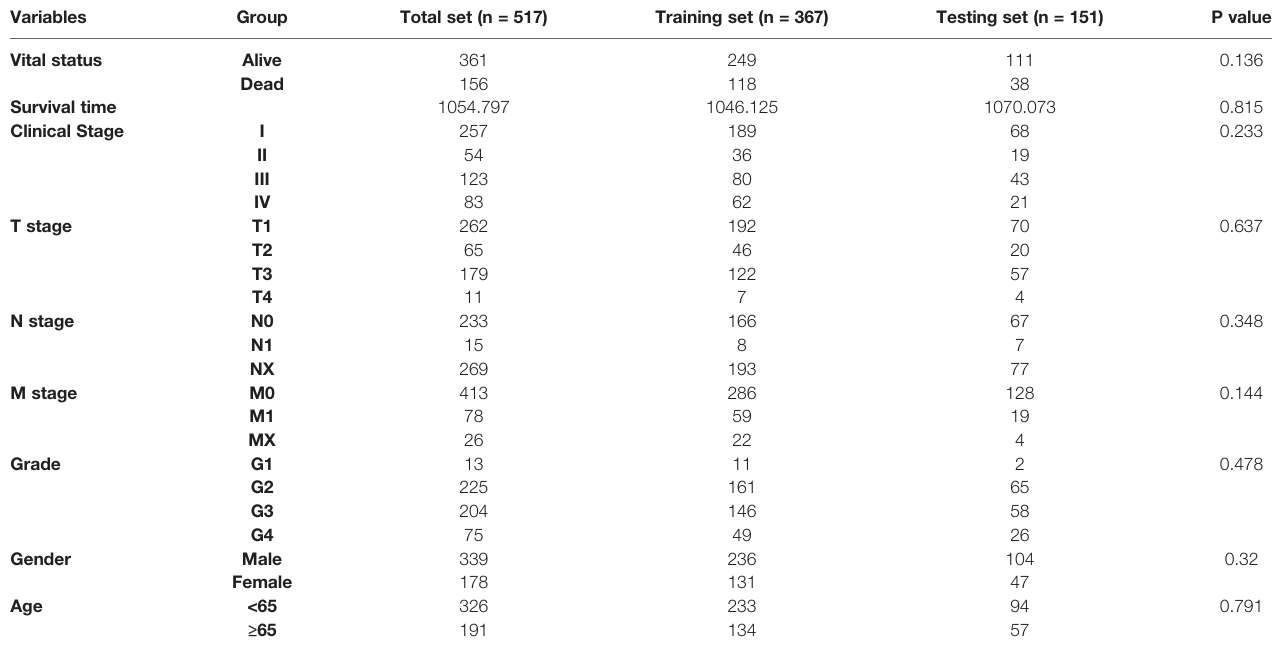
TABLE 1 | The clinical characteristics of KIRC